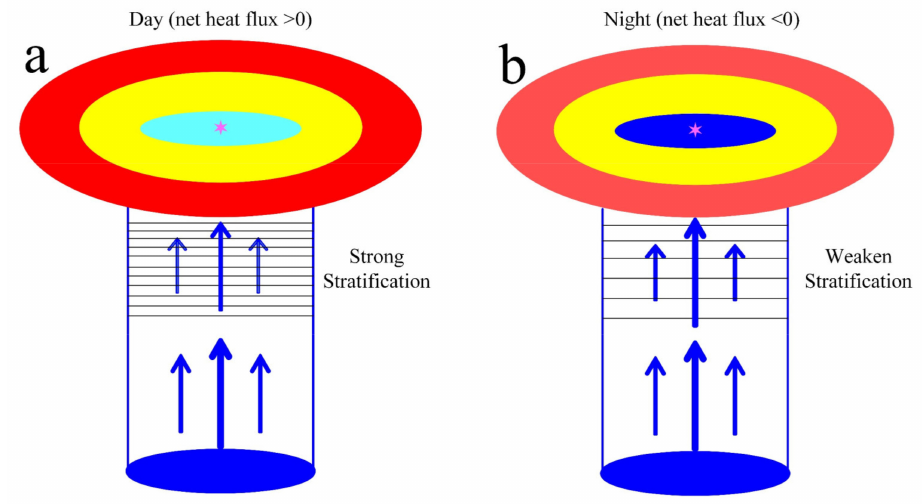
Figure 11. The mechanism sketch of short-term variations. The upwelling and stratification in upper ocean during daytime ( a ) and nighttime ( b ). The black lines represent the isotherms. The blue vectors represent the tidal mixing. The thickness of the arrow represents the strength of tidal